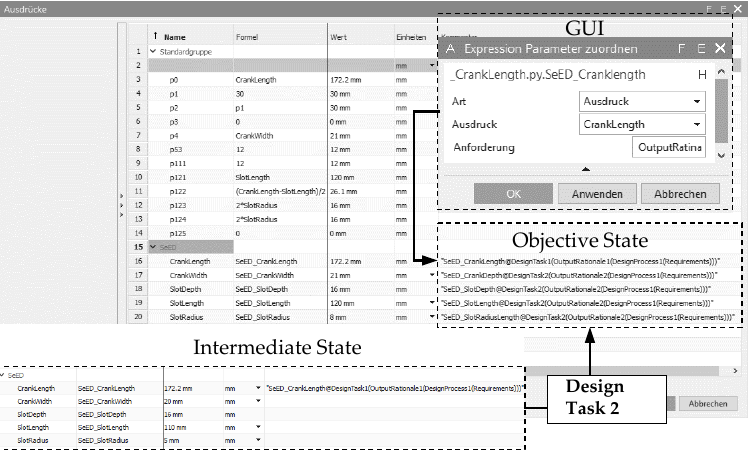
Figure 10. Illustration of the GUI used to annotate the Rationale of Expressions and the Intermediate State and the Objective State in the Expression tab of the CAD model to demonstrate how States can be distinguished by utilizing Design Tasks as